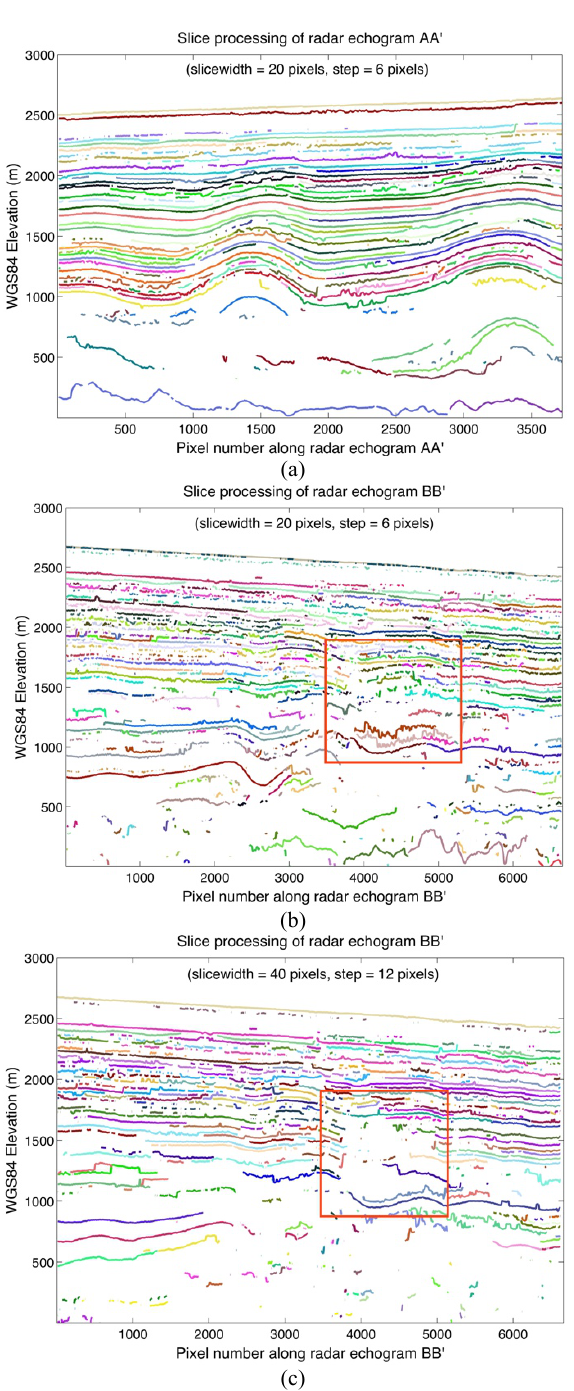
Figure 10. Results of line detection on the radar echograms: (a) extracted linear features along radar echogram AA’ (slice width of 20 pixels, step of 6 pixels); (b) extracted linear features along radar echogram BB’ (slice width of 20 pixels, step of 6 pixels); (c) extracted linear features along radar echogram BB’ (slice width of 40 pixels, step of 12 pixels).